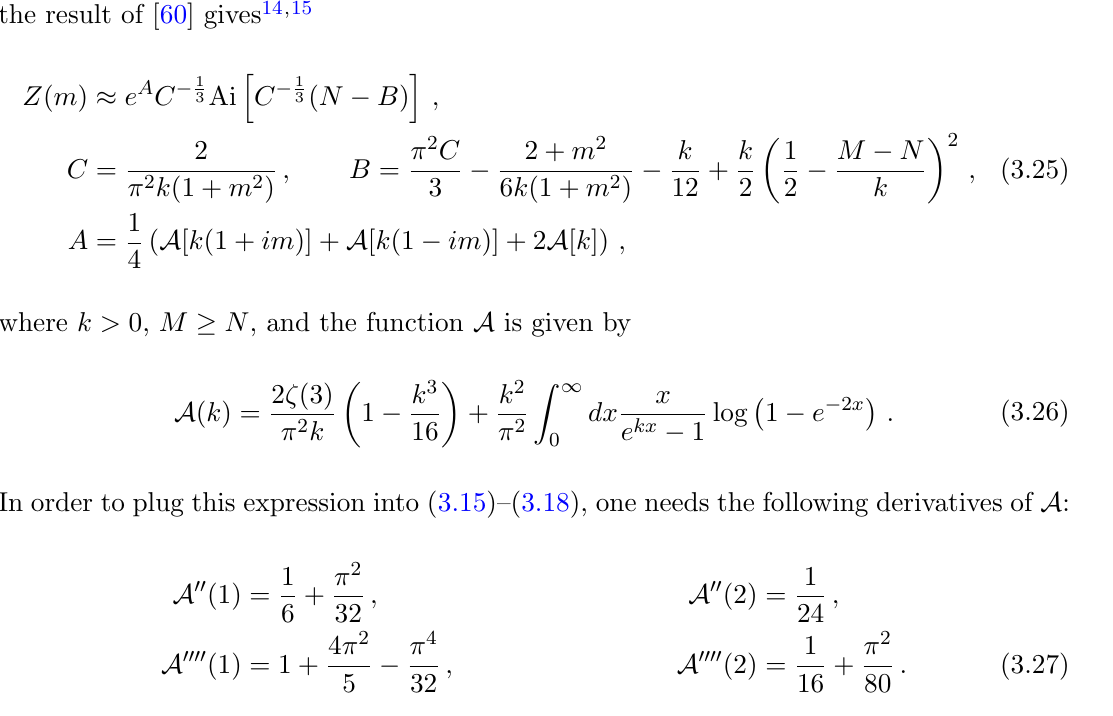
Fermi gas of N particles with kinetic energy T ( p ) = log cosh( (cid:25)p ) and potential energy U ( q ) = log cosh( (cid:25)q ). Phase space quantization and statistical physics techniques allow one to calculate the S 3 partition function to all orders in 1 =N , and this expansion resums into an Airy function. The S 3 partition function in the presence of a mass deformation was computed using the same method in